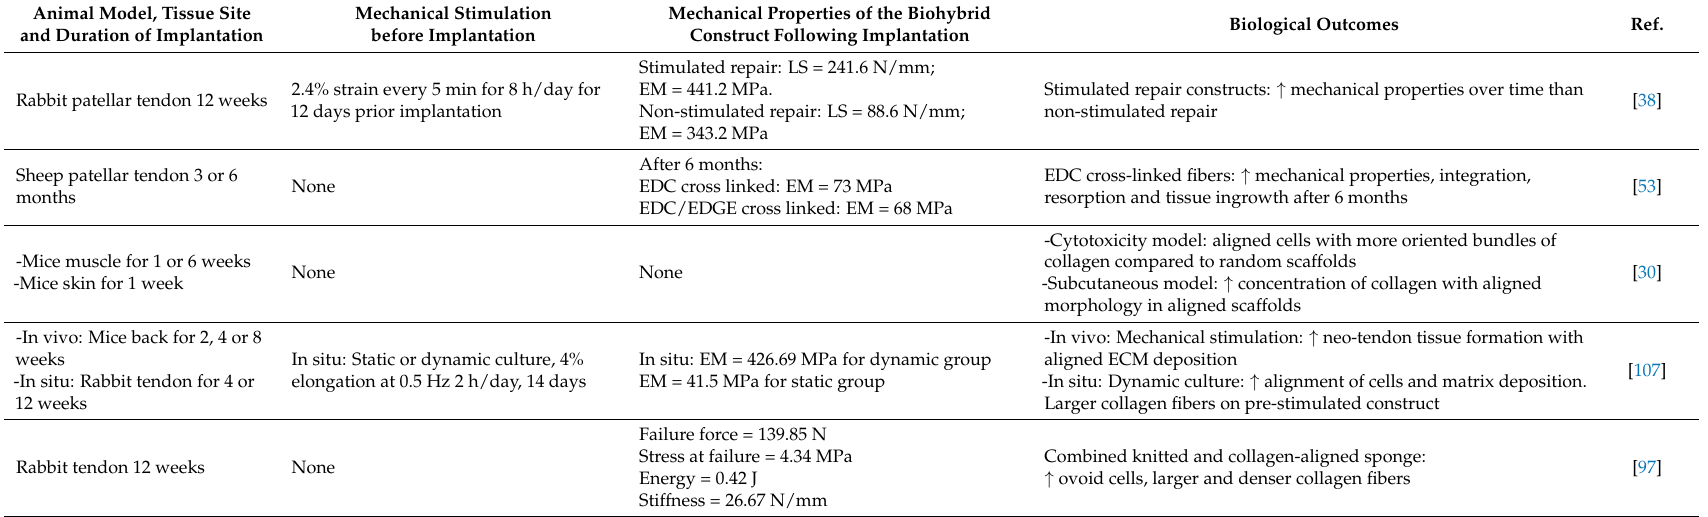
Table 3. In vivo performances of biohybrid construct in tendon tissue engineering ( ↑ =